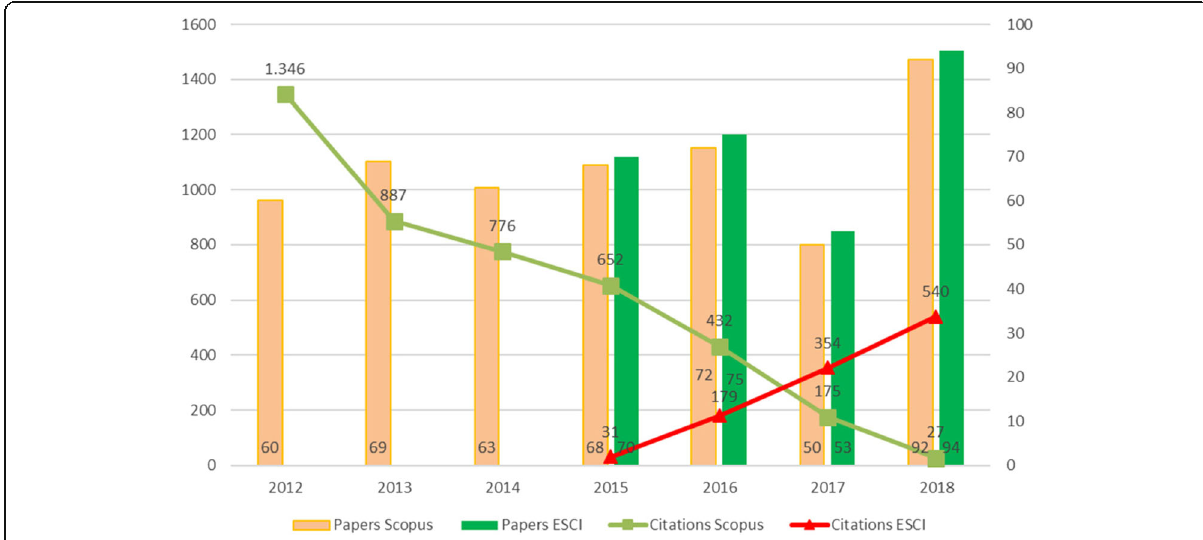
Fig. 1 Annual evolution of published papers and citations in Scopus and ESCI databases